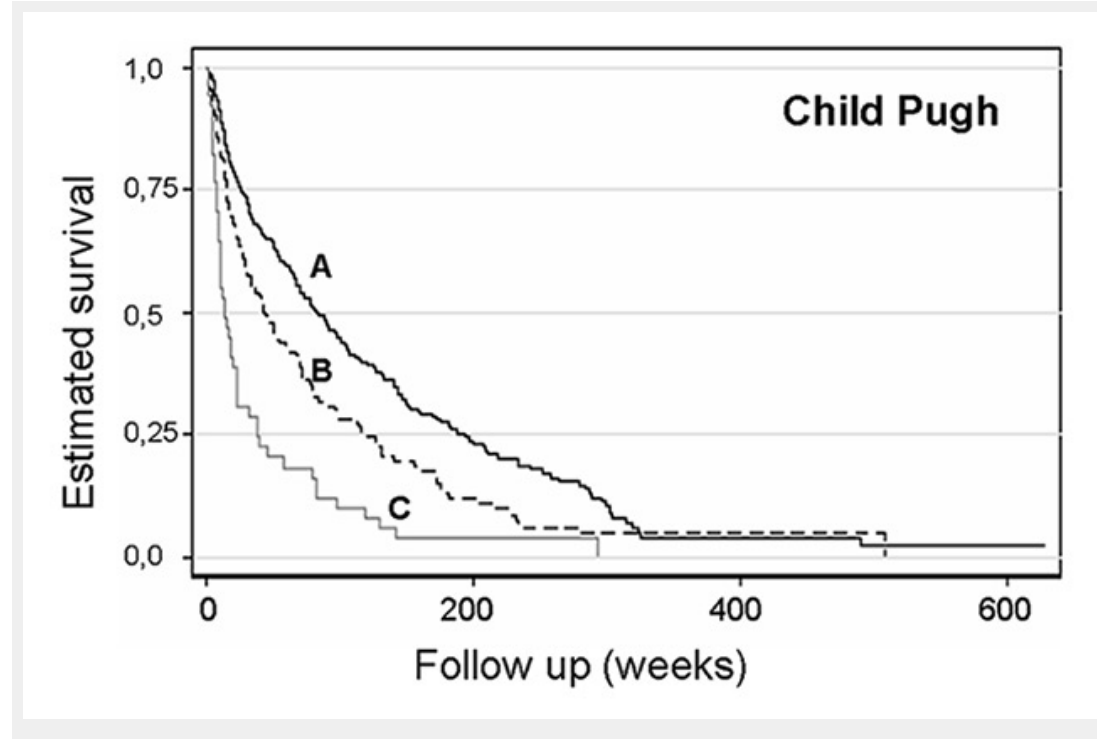
Figure 2 Kaplan-Meier curve for survival by Child Pugh score in patients with hepatocellular cancer (n = 301, 132 and 51 for Child Pugh A, B and C, respectively; p <0.001 for difference between the